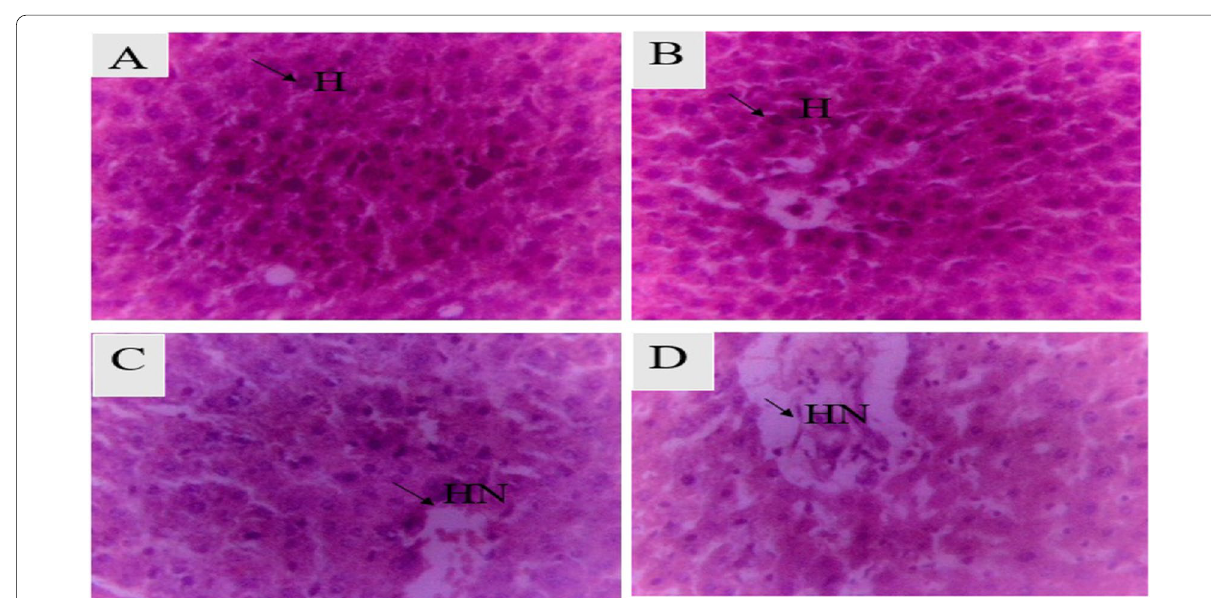
Fig. 2 Photomicrographs of liver sections of rats following 28-day oral administrations of Culcasia angolensis leaves extract (CAE) (haematoxylin and eosin-stained at 250 magnification). A Control (distilled water); B CAE (125 mg/kg); C CAE (250 mg/kg); D CAE (500 mg/kg), H (normal × hepatocytes); HN (moderate hepatocyte